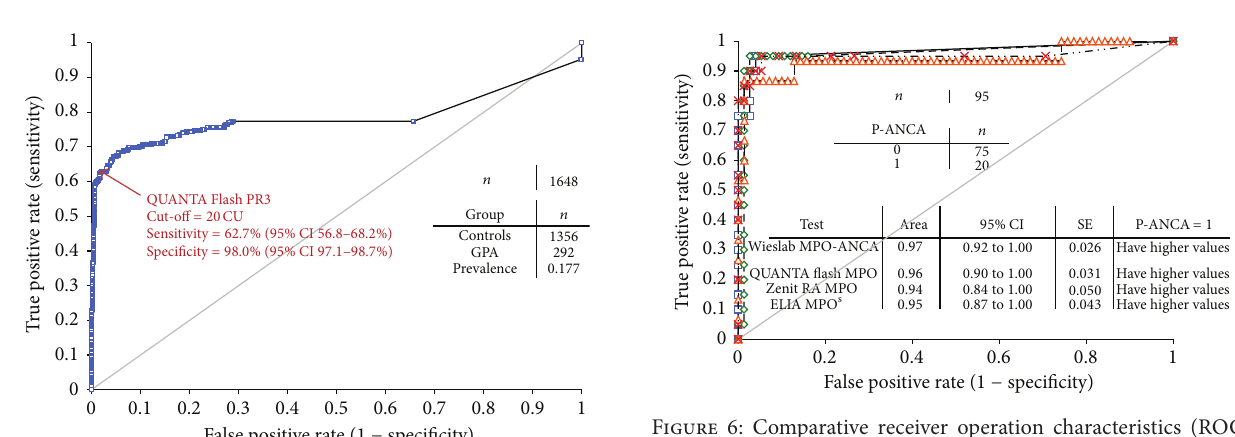
Figure 6: Comparative receiver operation characteristics (ROC) analysisof20P-ANCApositiveserumsamplestestedbyIIFtogether with 75 disease and control serum samples using a novel MPO CLIA and three other commercially available MPO assays revealed AUC values of 0.97 (Wieslab MPO-ANCA), 0.96 (QUANTA Flash MPO), 0.94 (Zenit RA MPO), and 0.94 (ELIA MPO s ) resulting in a relative sensitivity/specificity of 95%/96% (Wieslab MPO), 95%/96% (QUANTA Flash MPO), 86.7%/95.7% (Zenit RA MPO), and 95%/94.7% (ELIA MPO s ) against a positive P-ANCA result by IFA, respectively